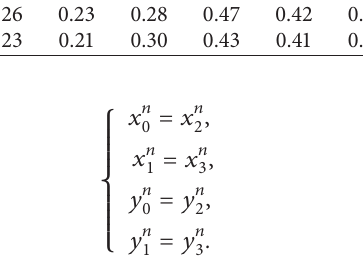
Figure 1: Dynamic behaviors of systems (36) and (37) with three sets of different initial conditions when r r Table 1: Different initial values for x n x 0 x 0 1 2